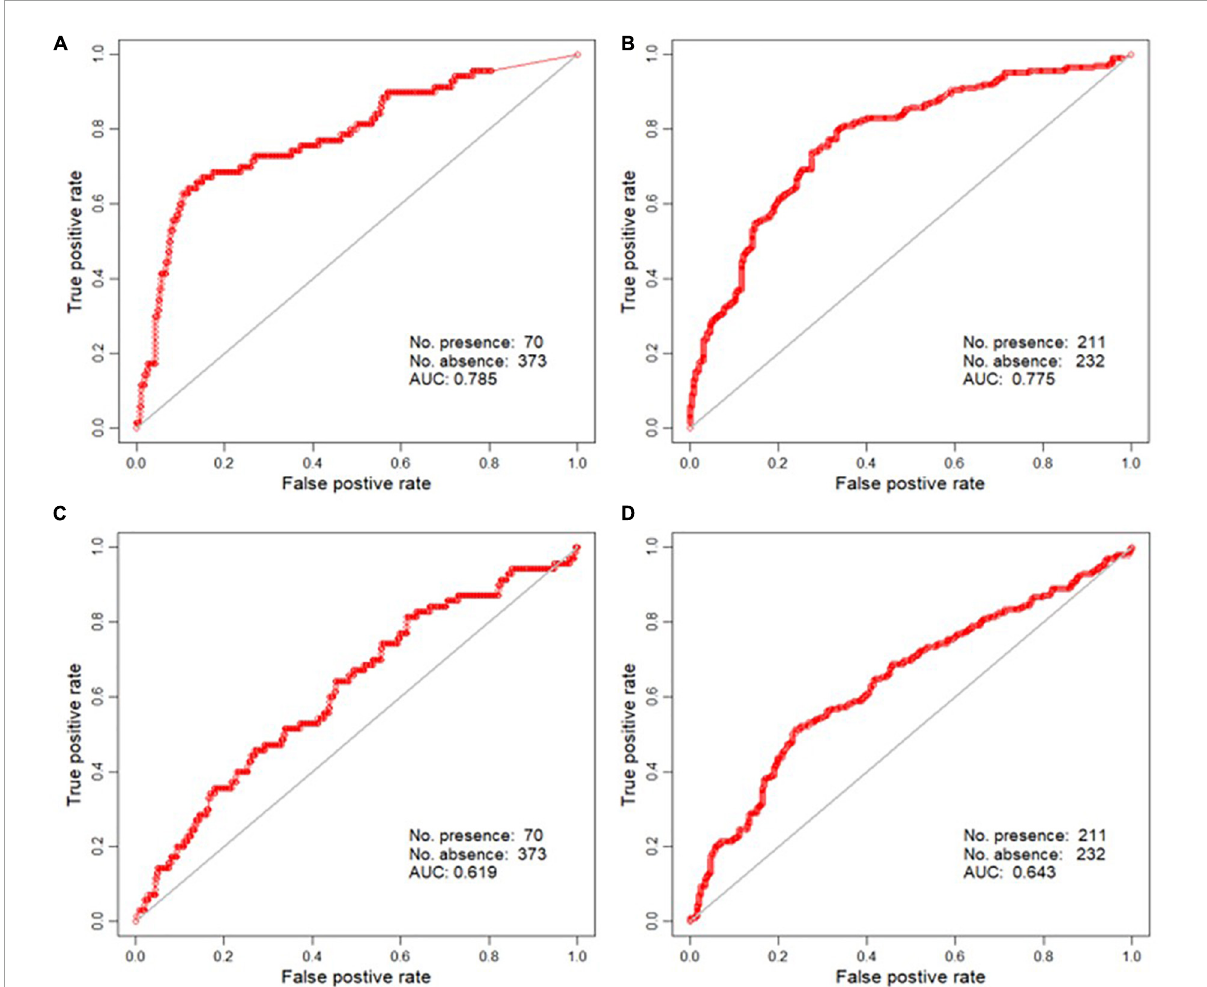
FIGURE4 Receiver operating curve (ROC) plot of the regression kriging (RK) ( A: Ambrosia artemisiifolia , B: Ambrosia trifida ) and the Maxent result ( C: A. artemisiifolia , D: A. trifida